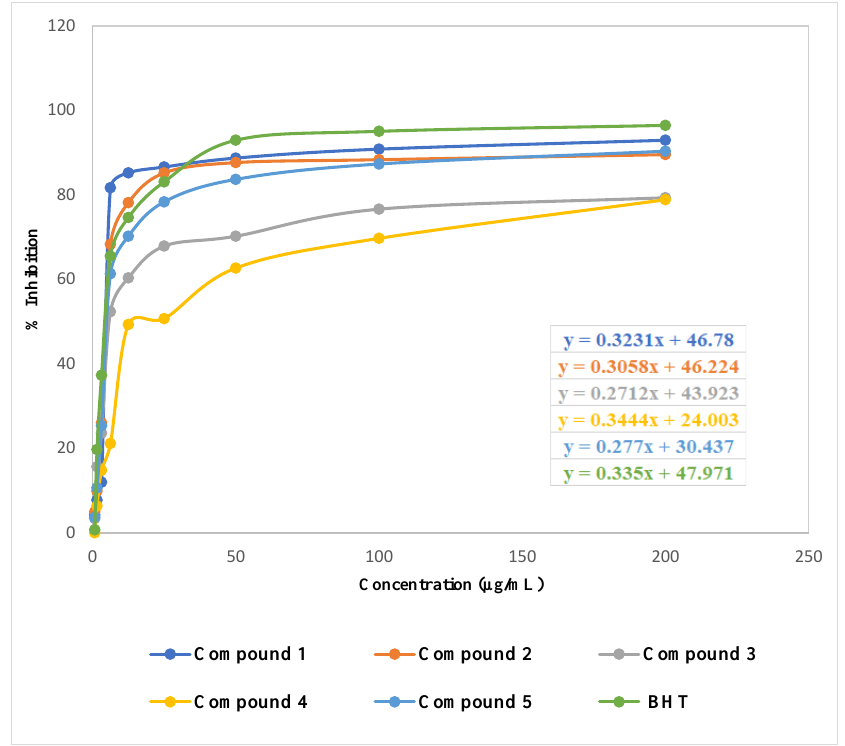
Figure 4. Linear regression equations (IC 50 ) of Butylated Hydroxytoluene (BHT) and isolated phy- tochemicals of Glycosmis cyanocarpa.